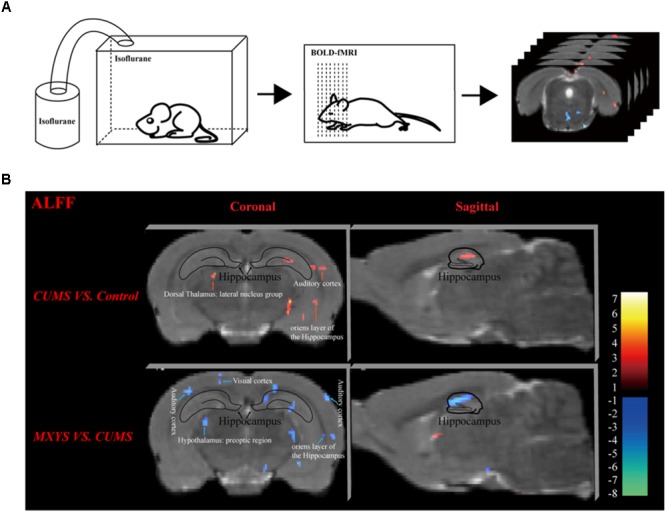
Effect of MXYS on BOLD–fMRI signal in brain regions of mice. (A) Schematic representation of the process for fMRI experiment. (B) Images of coronal and sagittal planes show the changes of BOLD–fMRI signal in the hippocampal region between different groups according to the results of the ALFF analysis. The voxel-level height threshold was P < 0.005 (uncorrected) and the cluster-extent threshold was 20 voxels.